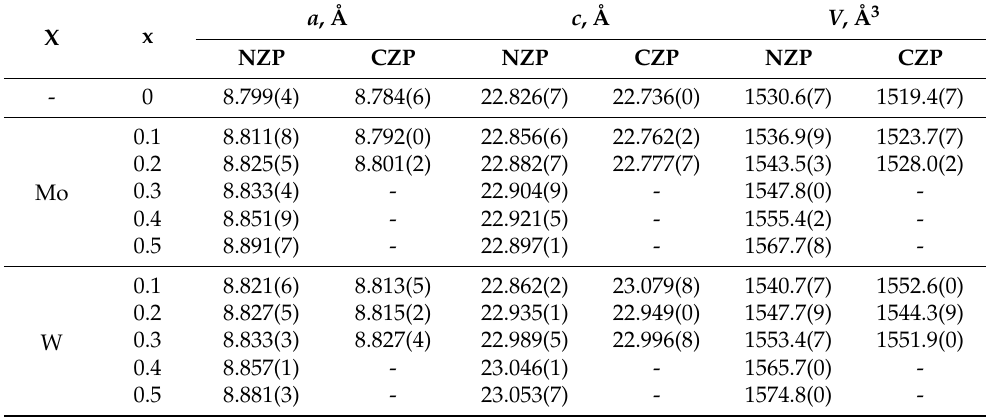
Table 1. Crystallographic characteristics of the phosphates Na 1-x Zr 2 (PO 4 ) 3-x (XO 4 ) x (denoted